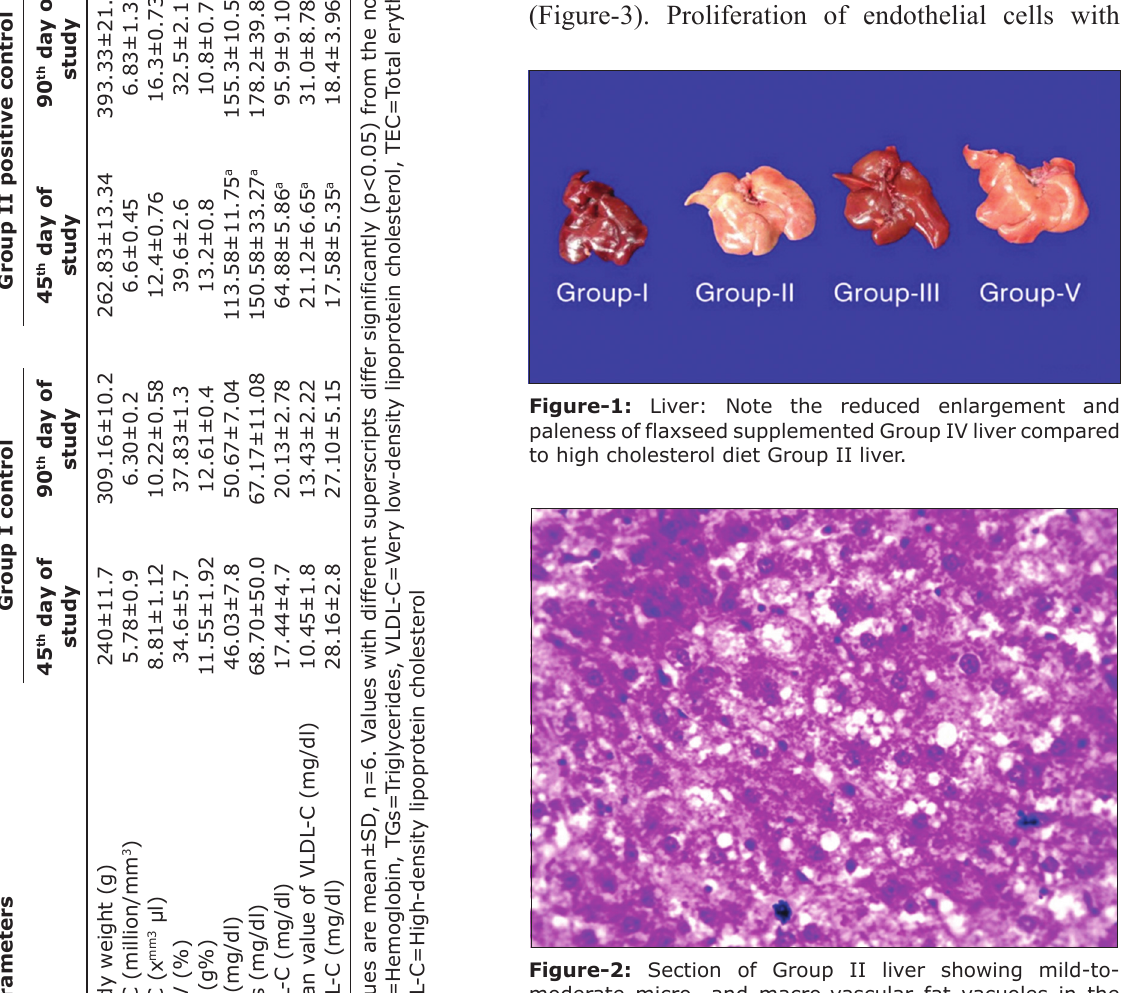
(Figure-1). HCD-fed Group II rats microscopically revealed varying sizes of fat vacuoles in various zones of the hepatocytes (Figure-2). These changes were very mild and less conspicuous in flaxseed control Groups I and III throughout the study period (Figure-3). Proliferation of endothelial cells with